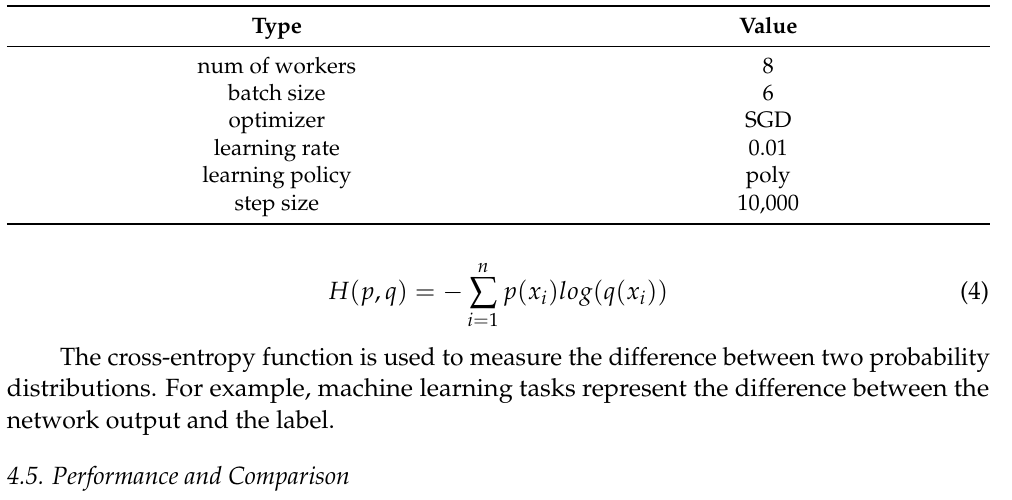
Table 1. Hyper-parameter.